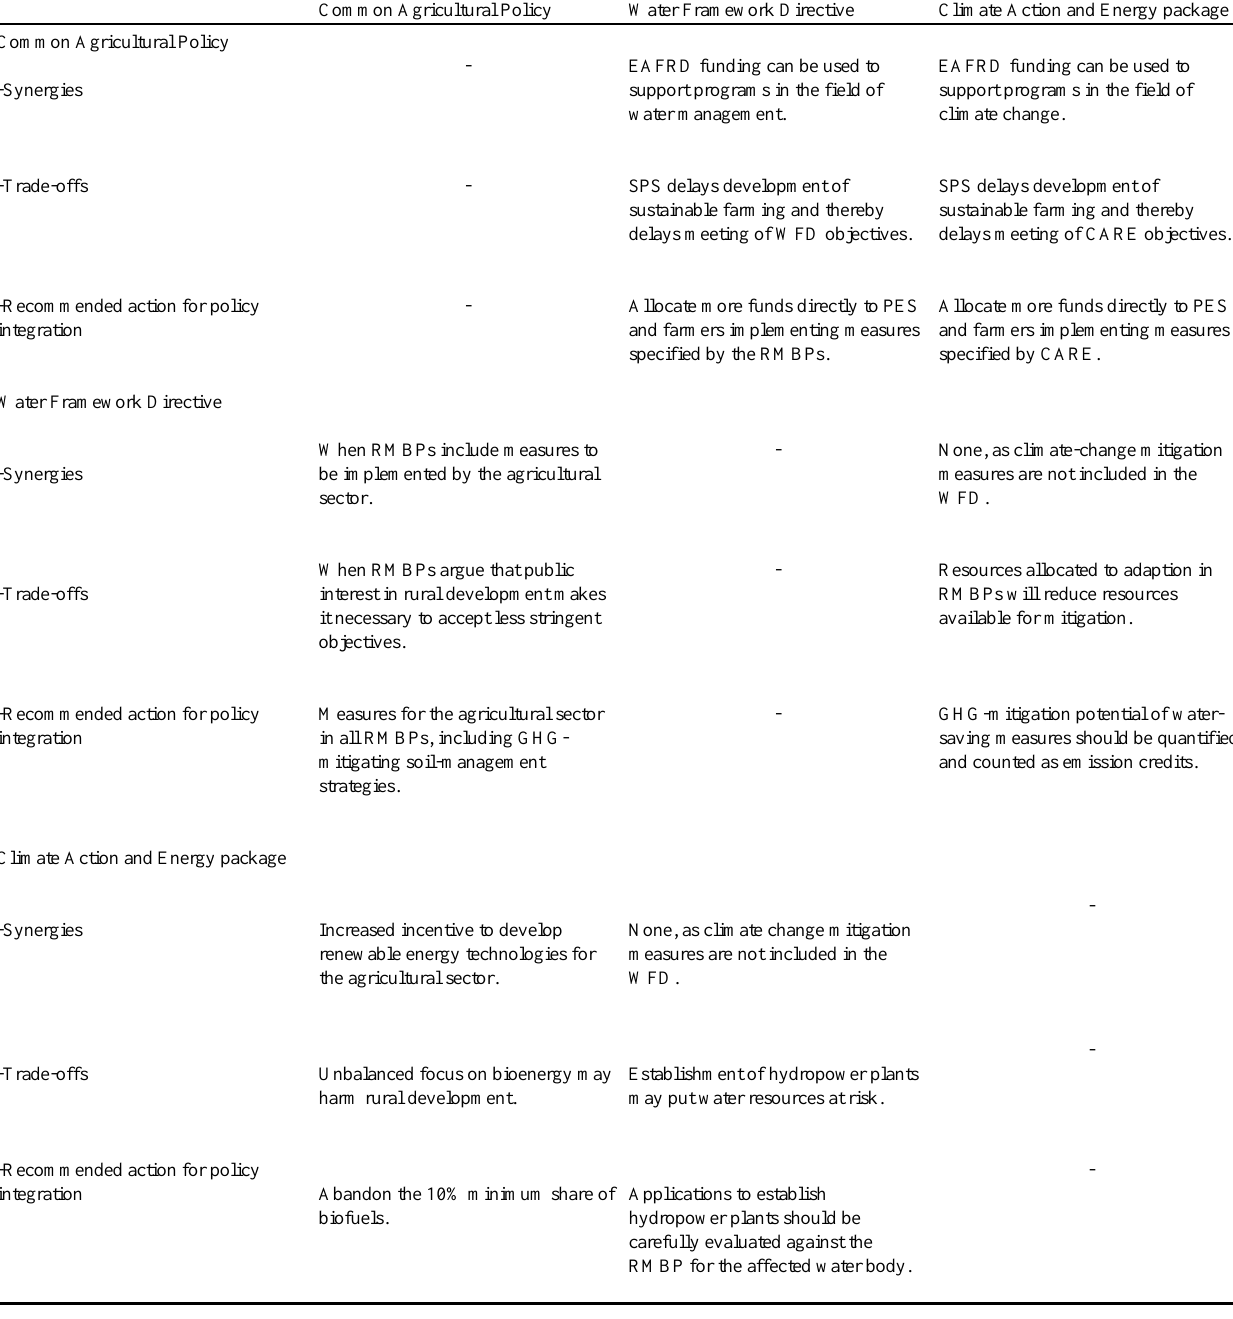
Table 3. Synergies and trade-offs among the Common Agricultural Policy (CAP), Water Framework Directive (WFD), and Climate Action and Energy (CARE)